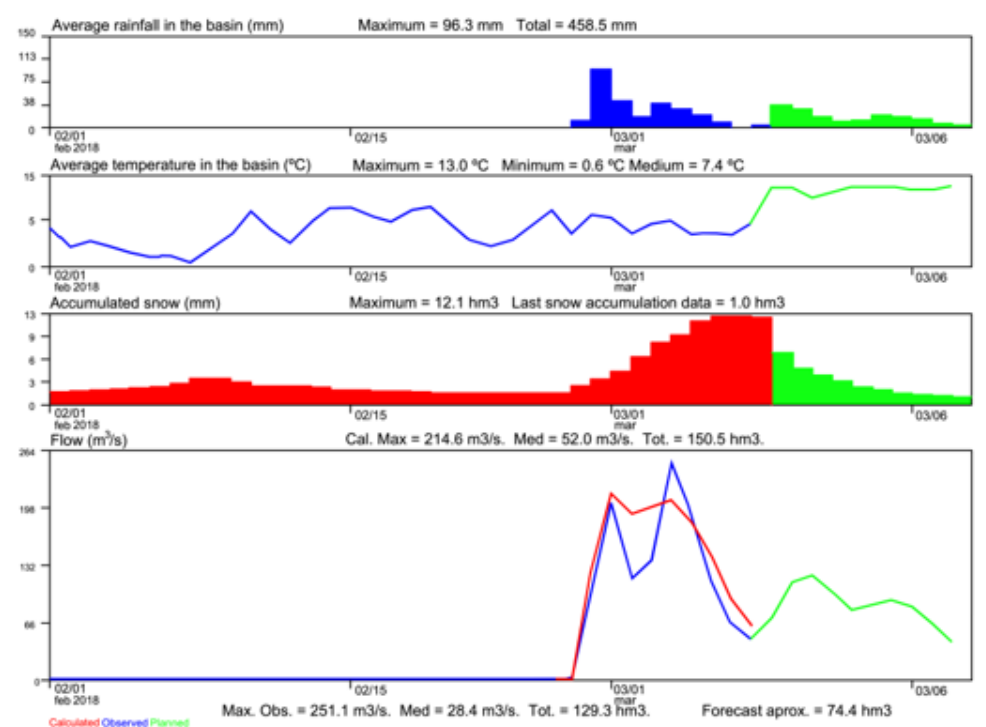
Figure 10. Flow forecast graph (green) in the Rosarito reservoir, with the AEMET (most unfavorable) temperature and rainfall predictions.